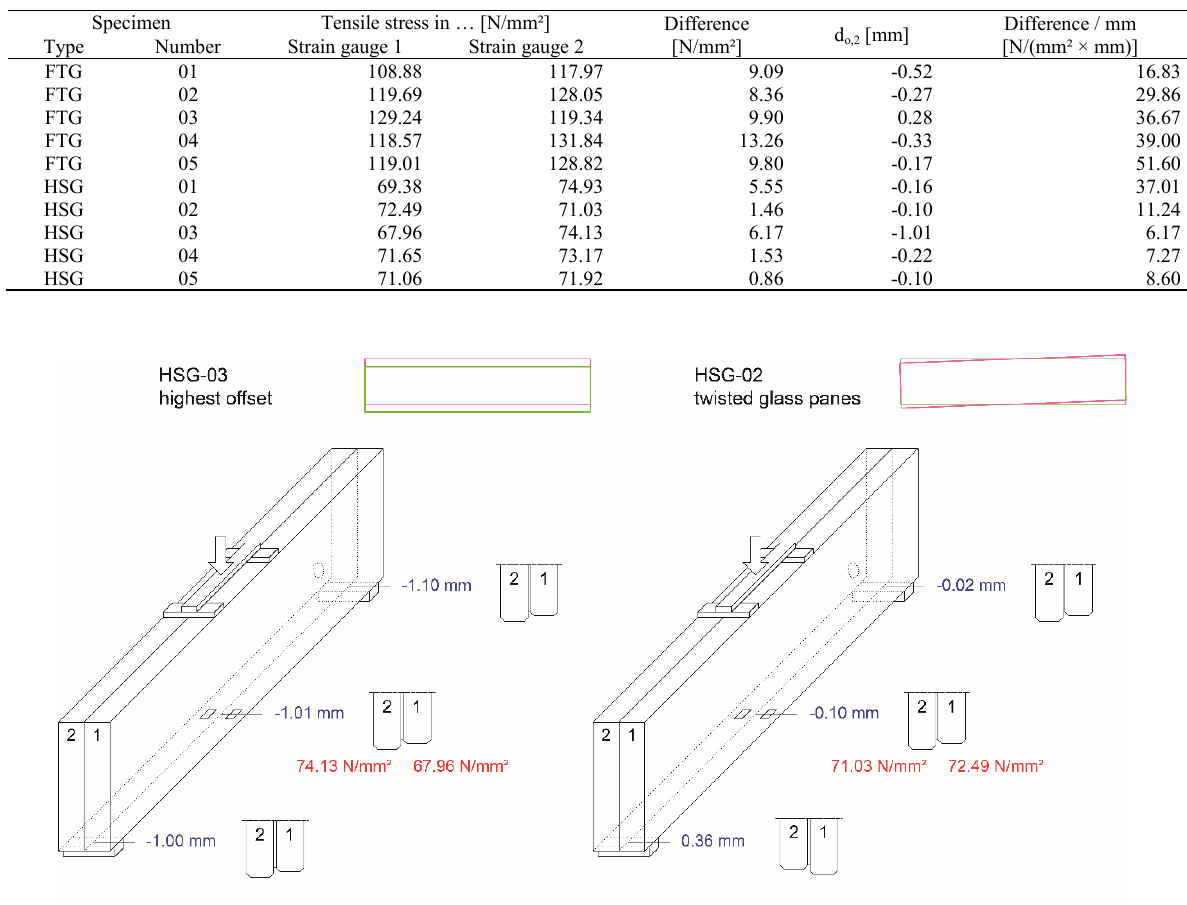
Fig. 8 Examples of specimens from the first run of the four-point bending